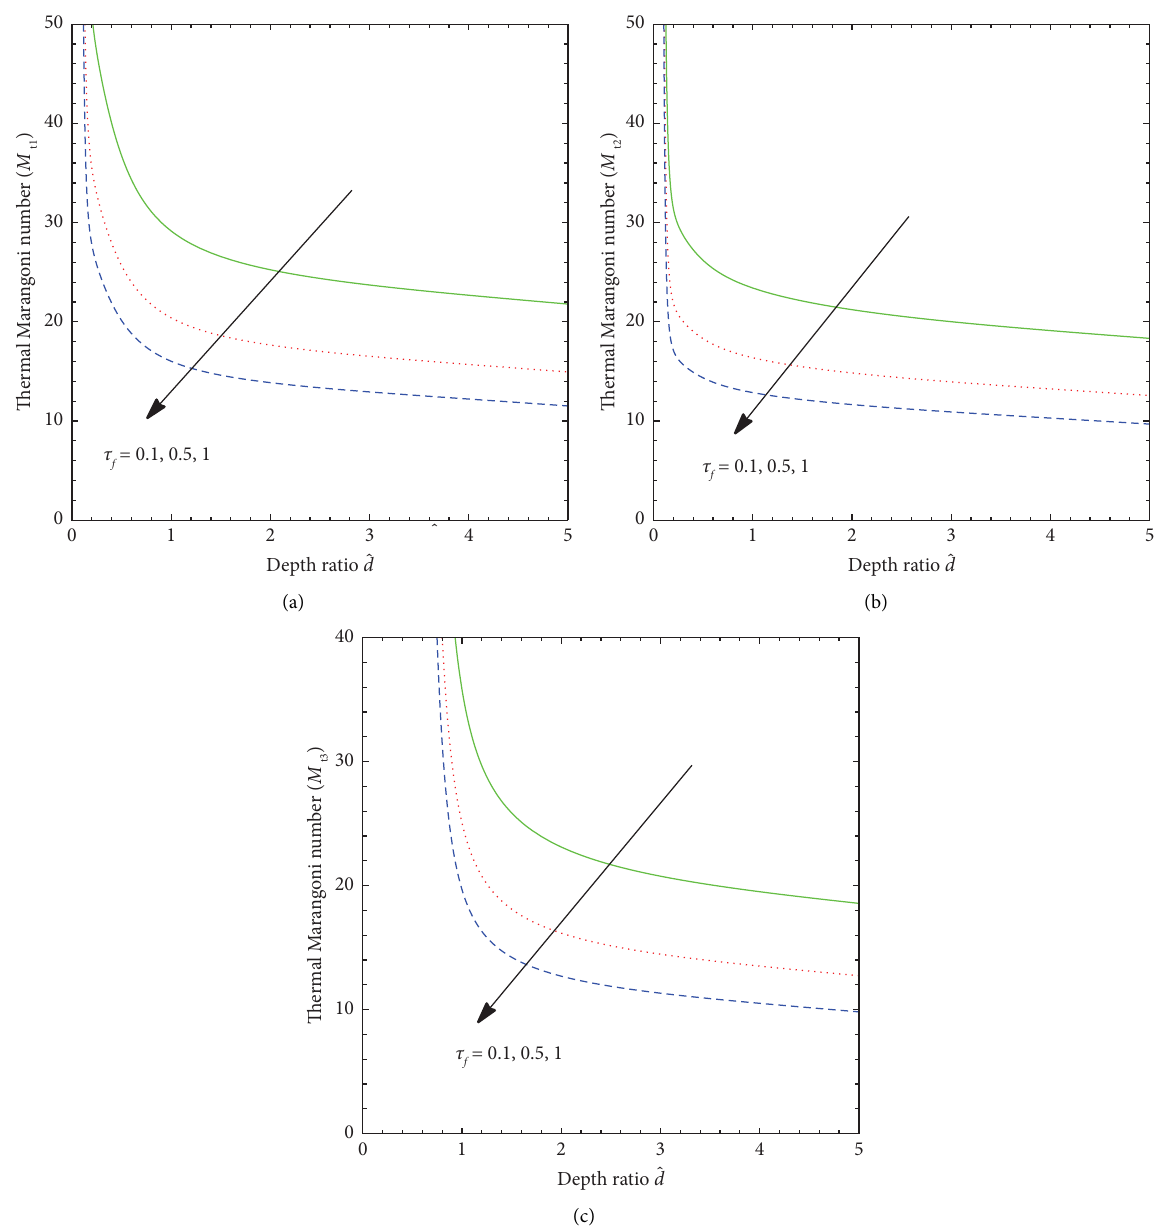
Figure 6: Te impact of the difusivity ratio τ M � S